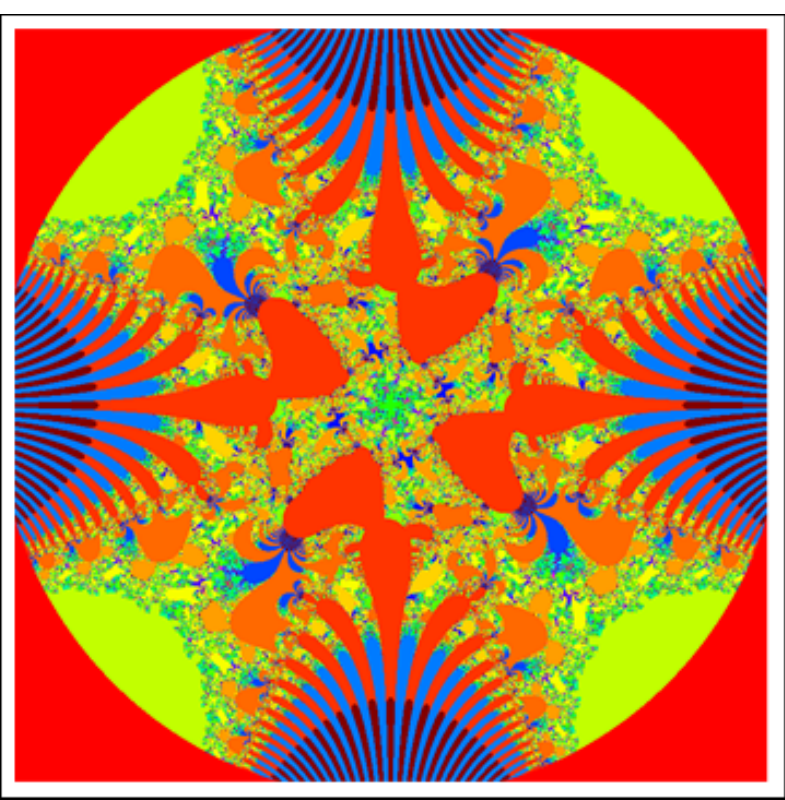
Figure 12. J-set for τ ( z ) = e z 4 + c via DKIS. The image execution time is 132.75 s.